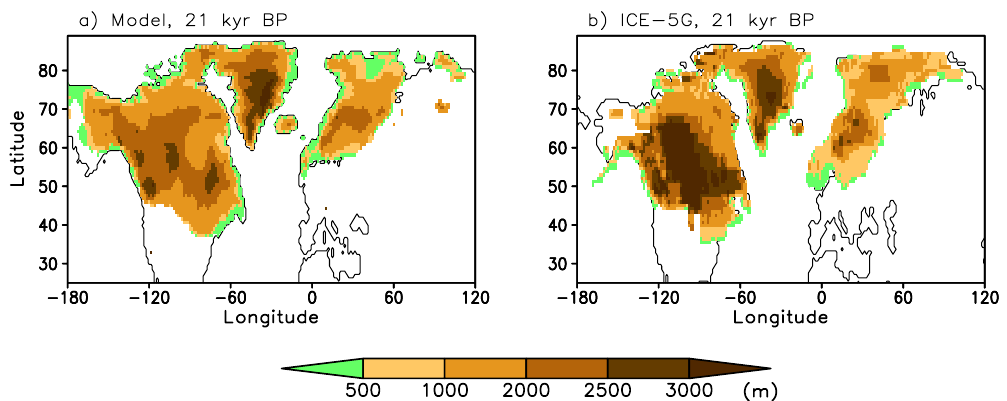
Fig. 5. Spatial extent and elevation of (a) simulated and (b) reconstructed (Peltier, 2004) ice sheets at the LGM.